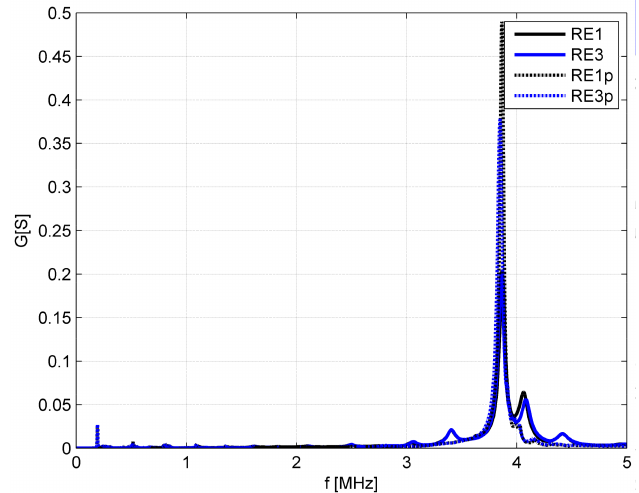
Figure 6. Conductance curves for two reference samples (RE1 and RE3) and respective free piezoelectric sensors before bonding (RE1p and